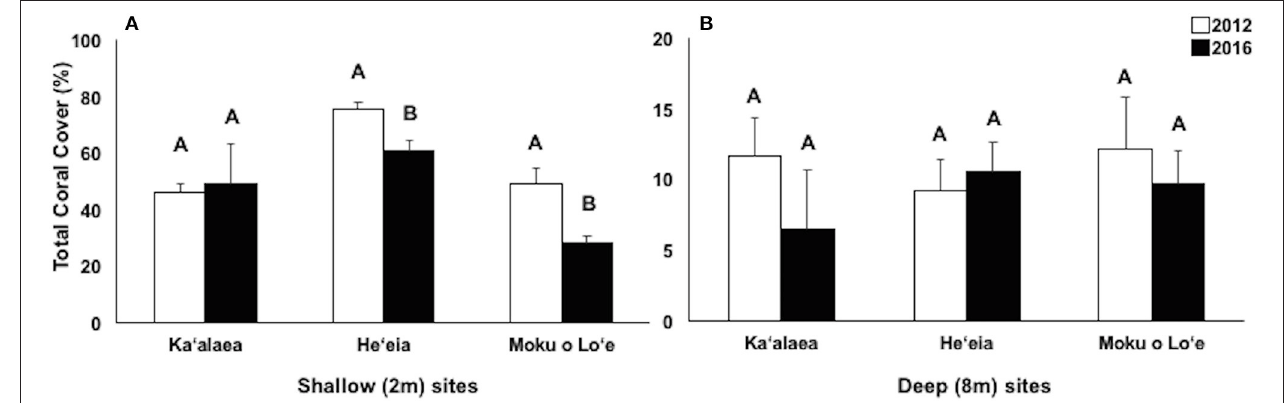
FIGURE 7 | Changes in total coral cover over time at long-term Coral Reef Assessment and Monitoring (CRAMP) sites at shallow (2m, A ) and deep (8m, B ) in North bay, Ka‘alaea; Central bay: He‘eia; and South bay: Moku o Lo‘e. Different letters within site indicate statistically significant differences between years at p <